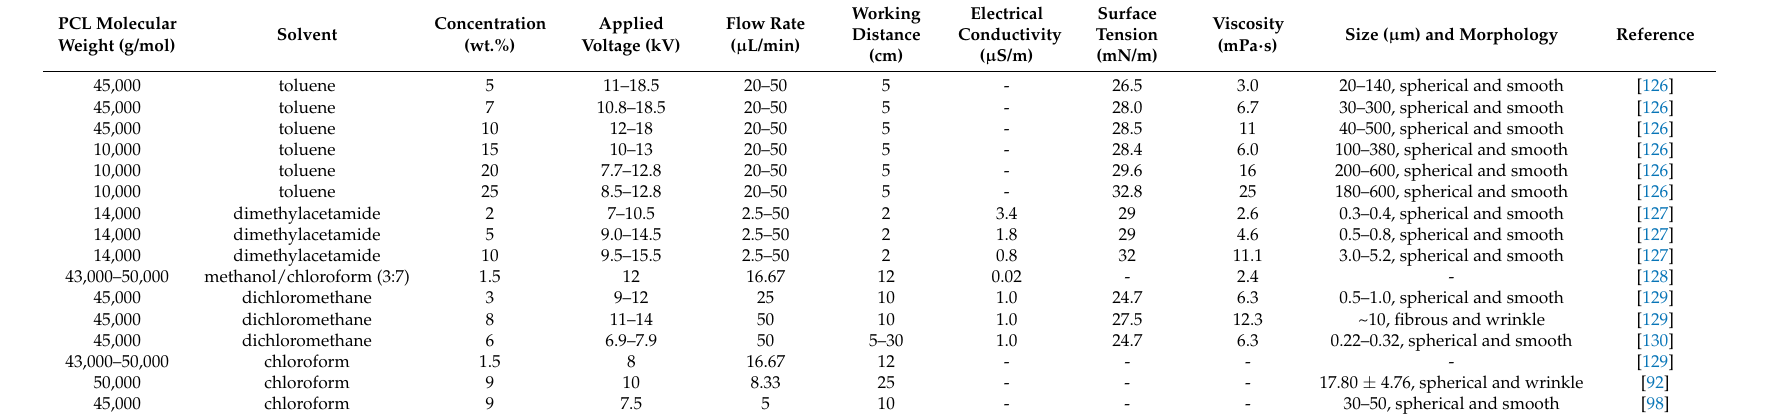
Table 3. Some solution properties for achieving cone jet during the PCL electrohydrodynamic